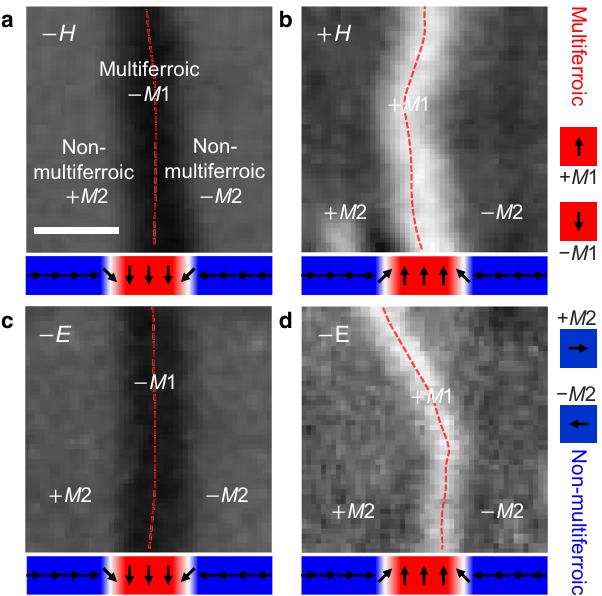
Fig. 4 Magnetoelectric fi eld control of multiferroic domain walls in a non- multiferroic environment. Using the same gray scale, a – d show equally sized regions on the same sample, yet imaged on different areas and in separate experiments. For experiments in a – c , a state as in Fig. 2e with + M 2 and − M 2 domains separated by a − M 1-like domain wall was prepared while for d , opposite M 2 domains are separated by a + M 1-like domain wall. Magnetic and electric fi elds are applied as labeled, with the + sign indicating out-of-plane orientation. Beneath each image, the associated order- parameter orientation is sketched in analogy to Fig. 2. a , b A magnetic fi eld ± H sets the magnetization of the multiferroic wall to ± M s and expands it into a ± M 1 multiferroic bulk domain with a 1:1 correspondence between the signs of H and M s . c , d An electric fi eld ± E sets the polarization of the multiferroic wall to ± P s and expands it into a multiferroic M 1 bulk domain. Because of the involvement of three order parameters, the sign of M s is not determined by the sign of P s ( E ) but rather by the history of the sample 27 . This is highlighted by c and d , where a fi eld − E induces a + M 1 or − M 1 domain,